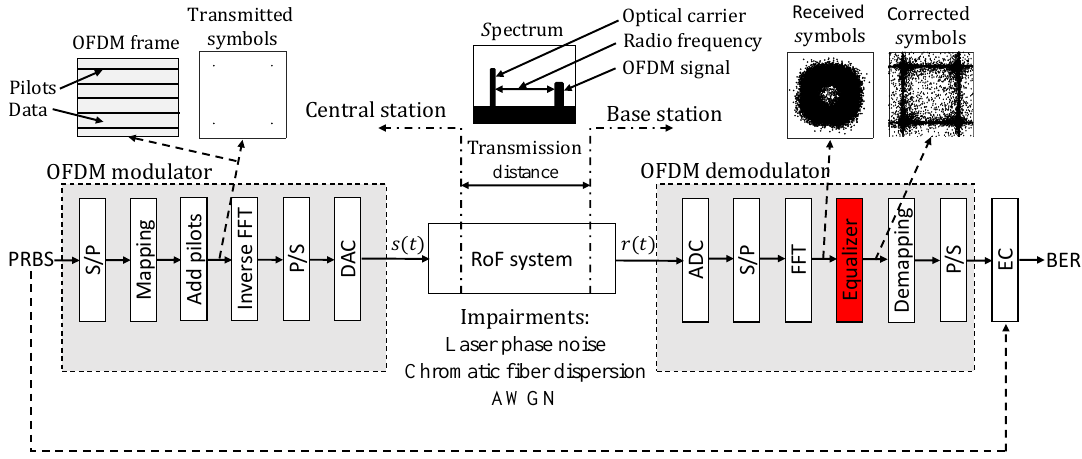
Figure 1. Block diagram of the simulated RoF system. PBRS: pseudo random binary sequence, S/P: serial-to-parallel, FFT: fast Fourier transform, P/S: parallel-to-serial, DAC: digital-to-analog converter, AWGN: additive white Gaussian noise, ADC: analog-to-digital converter, EC: error counting, and BER: bit error